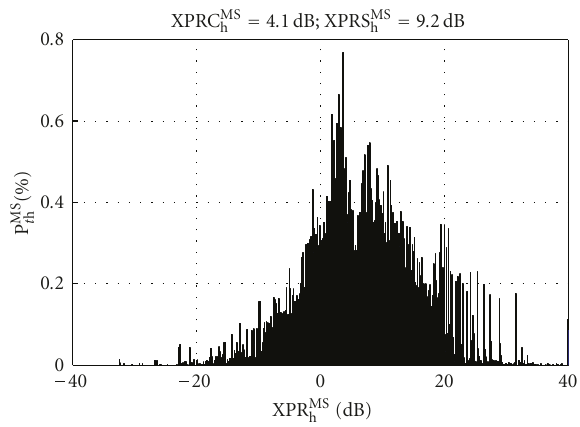
dependent on the t h